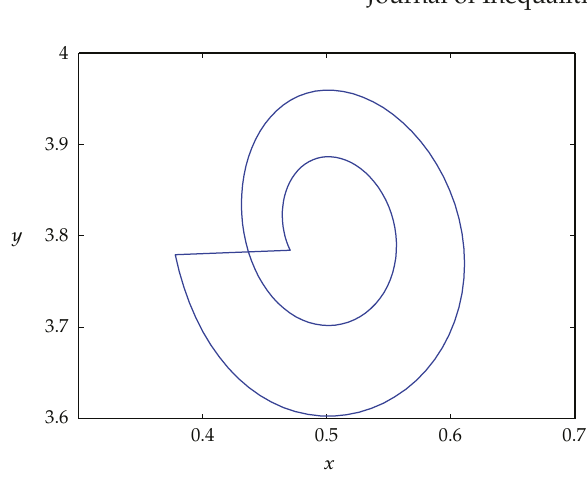
Figure 1: Phase portrait of a T -period solution of (cid:3) 1.3 (cid:4) for q (cid:6)